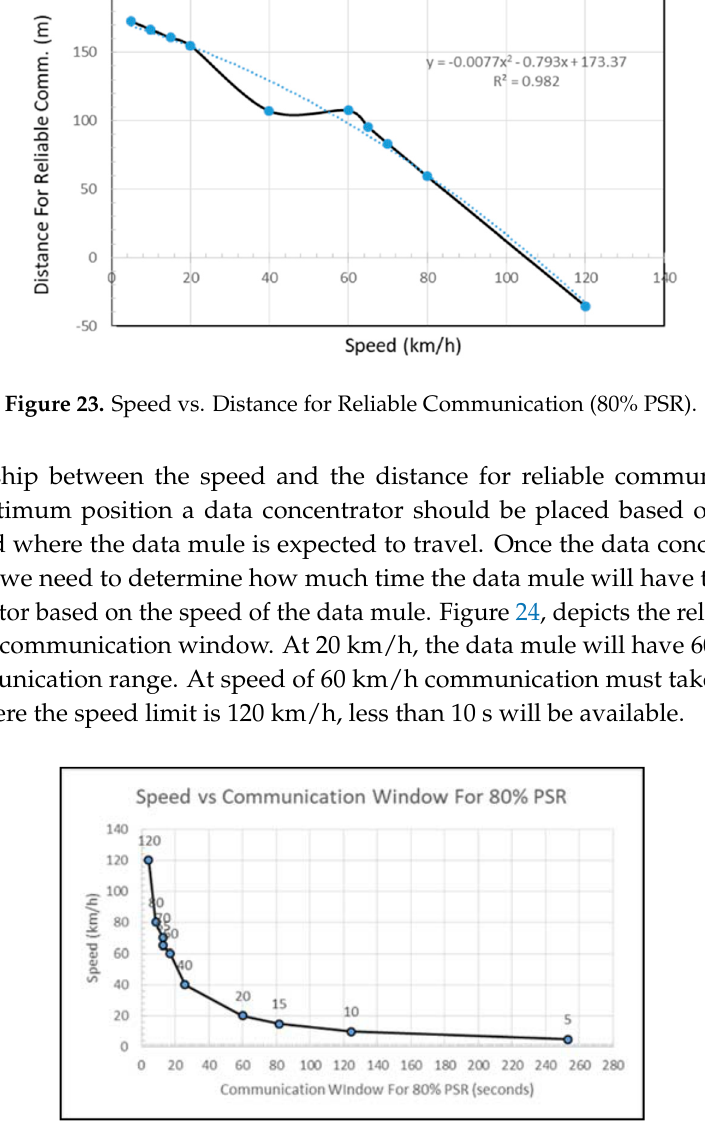
Figure 24. Speed vs. Communication Window for 80% PSR.